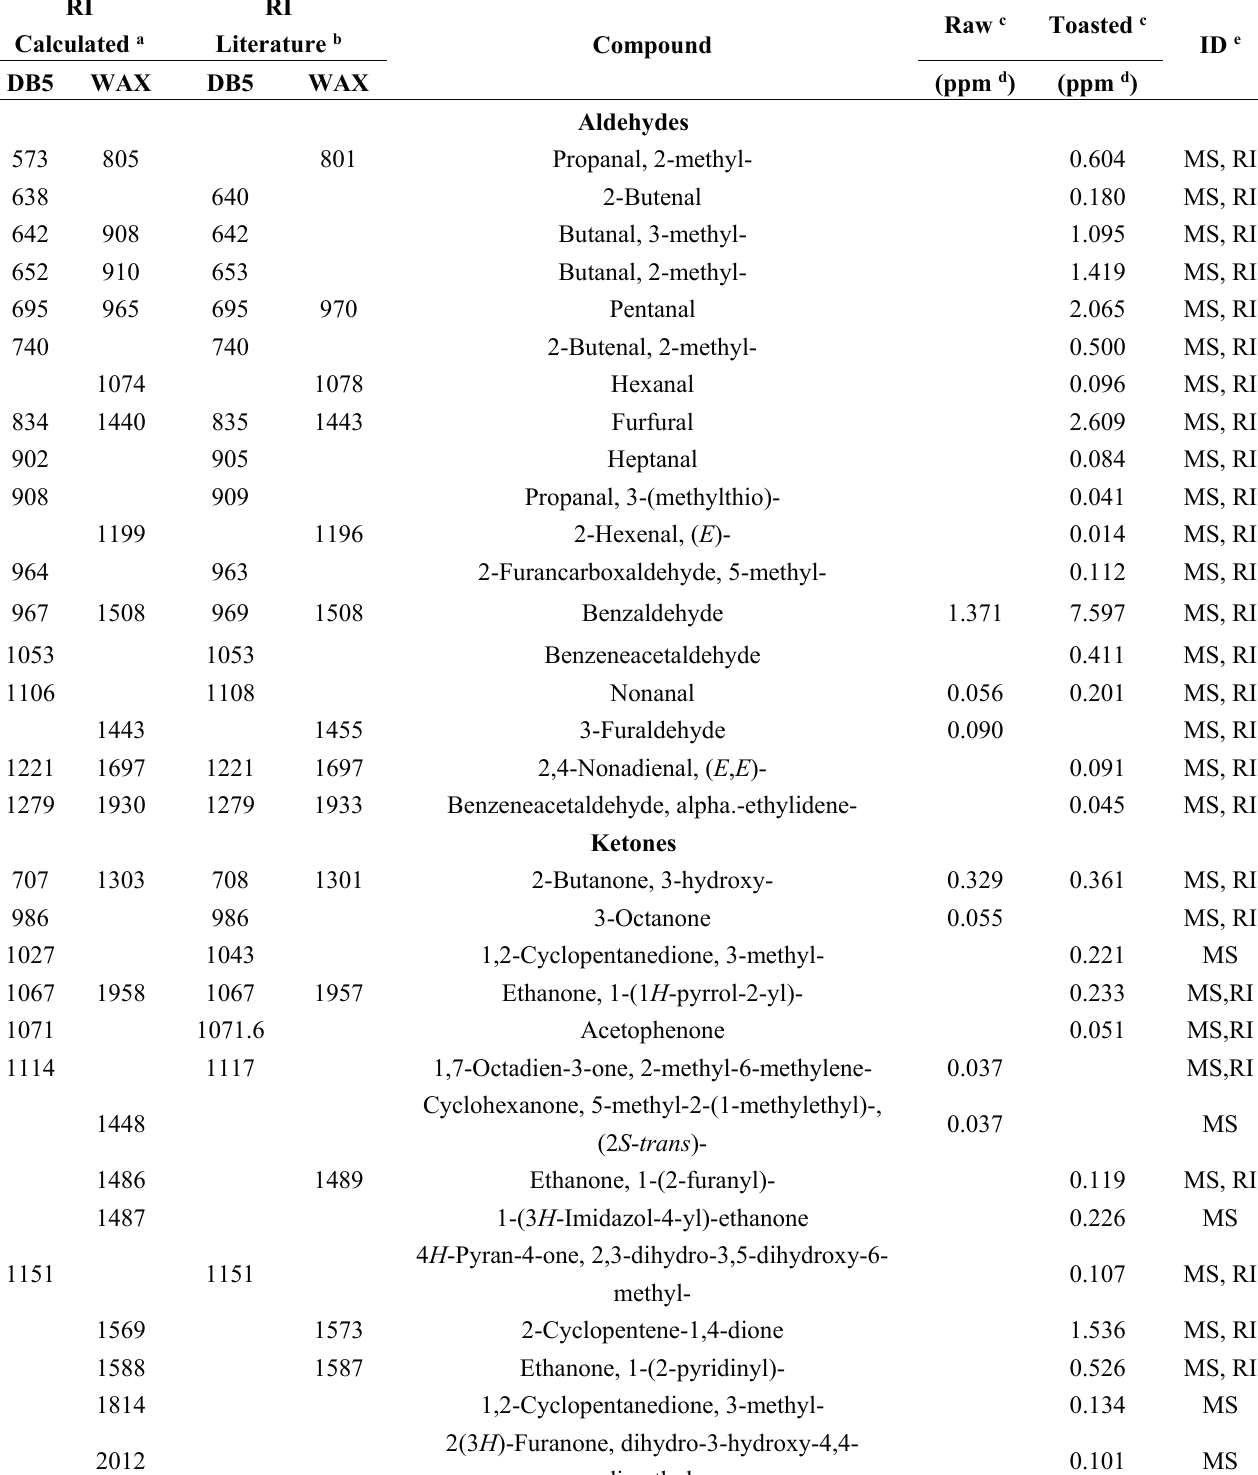
Table 5. Volatile compounds on raw and toasted black cherry